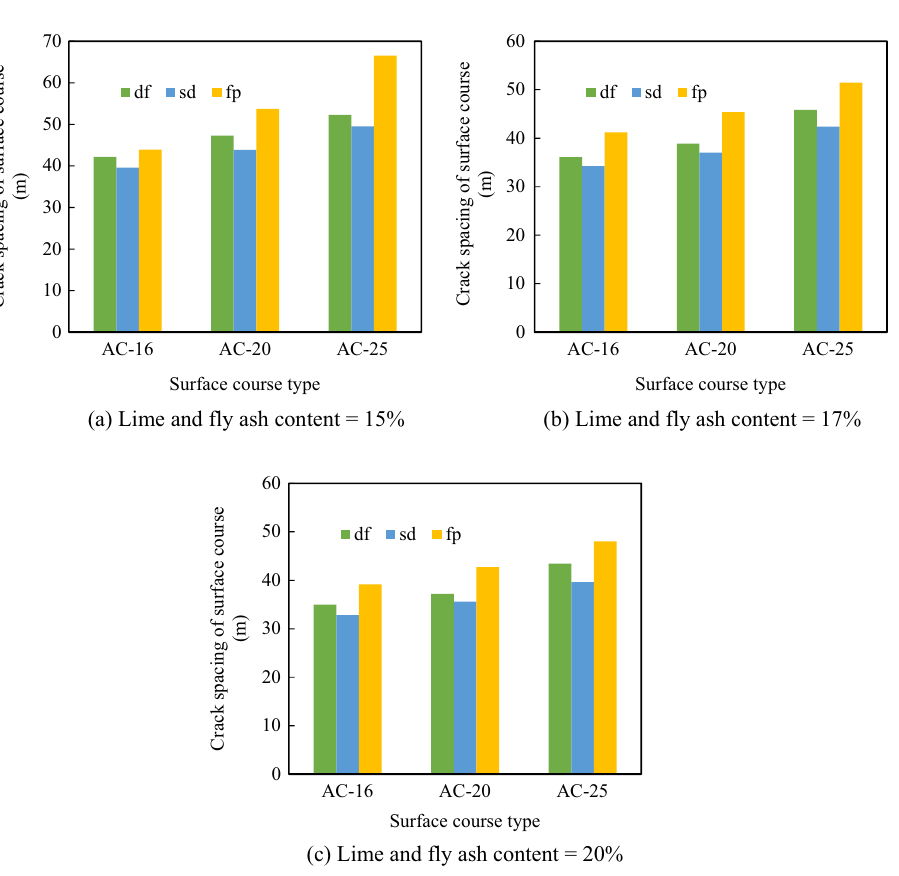
Figure 20. Crack spacings of the layer behind reflective cracks in different pavement